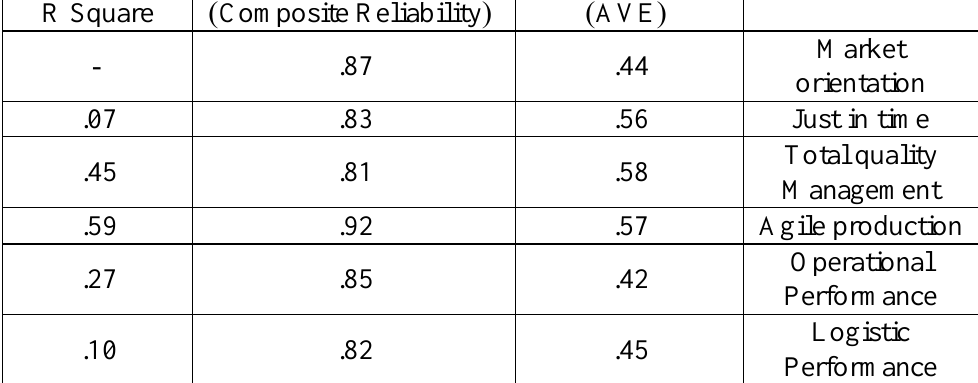
Table 4. The qualitative indicators of structural